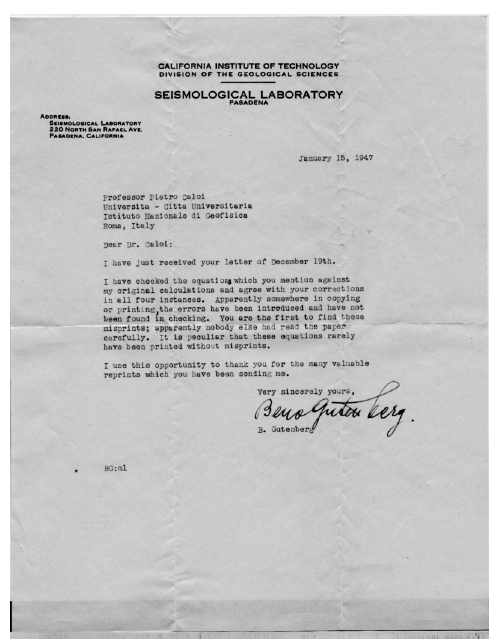
Fig. 5. Letter from Beno Gutenberg to Pietro Caloi in which he confirms to the Italian seismologist that the corrections to his work (Gutenberg, 1944) which he had pointed out, were right and he thanks him for the attention with which he had read his